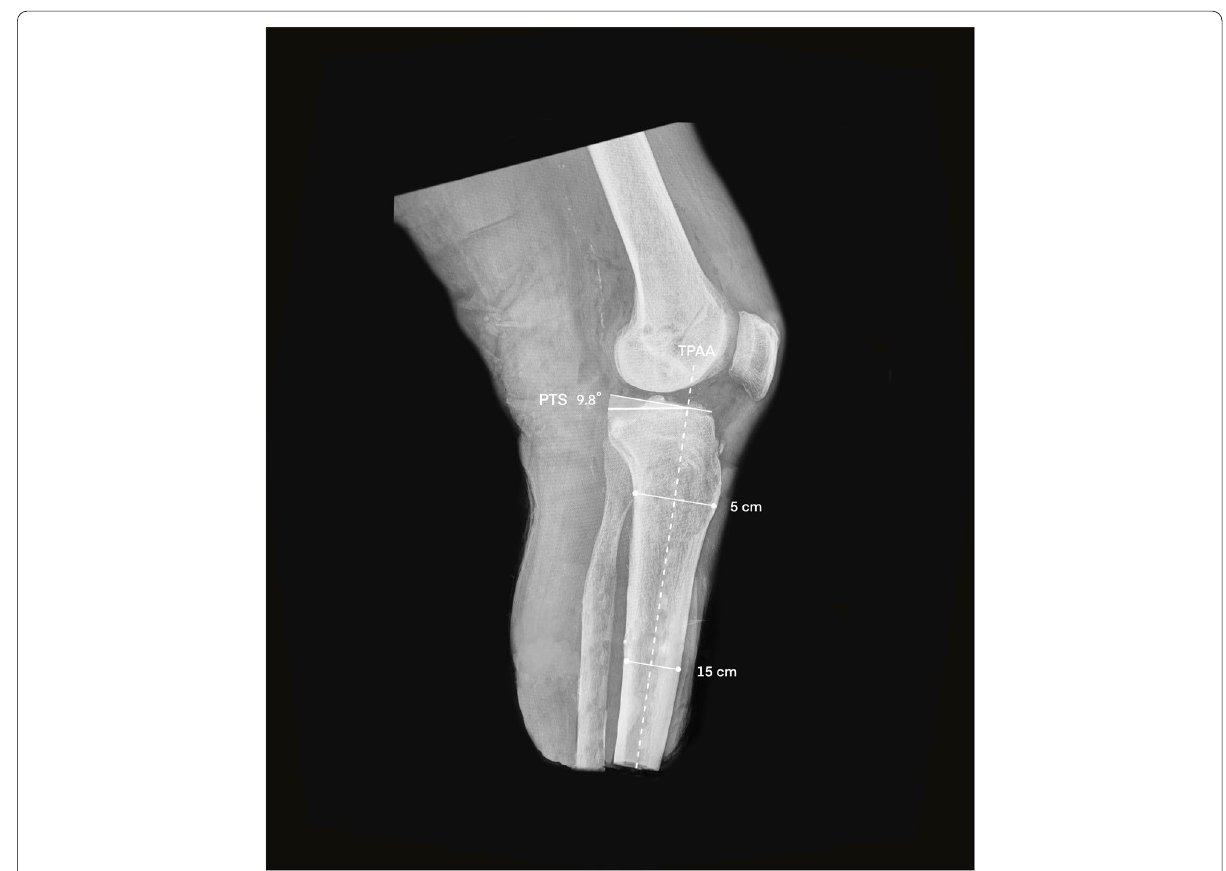
Fig. 1 Tibial slope measurement on lateral radiographs. The tibial proximal anatomic axis (TPAA) is drawn connecting the midpoints between the anterior and posterior tibial cortex at five and 15 cm distances to the joint line. A reference line is drawn perpendicular to this at the level of the tibiofemoral joint. The mean between the inclinations of both plateaus is also shown. The angle of this line to the reference line is defined as the posterior tibial slope